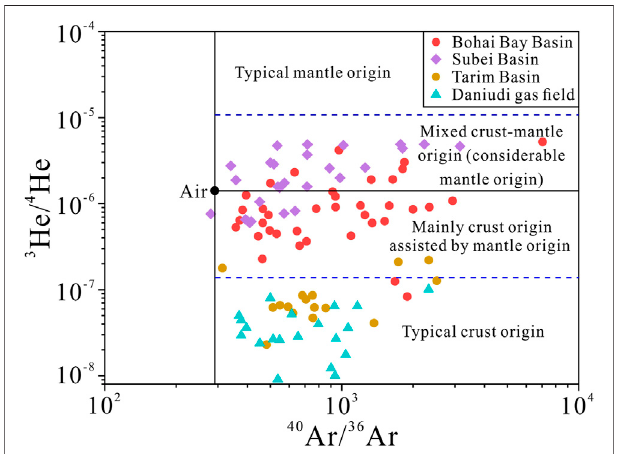
FIGURE 7 | Correlation of R/Ra versus 4 He/ 20 Ne of natural gas in the Daniudi gas fi eld [modi fi ed after Zhang et al .